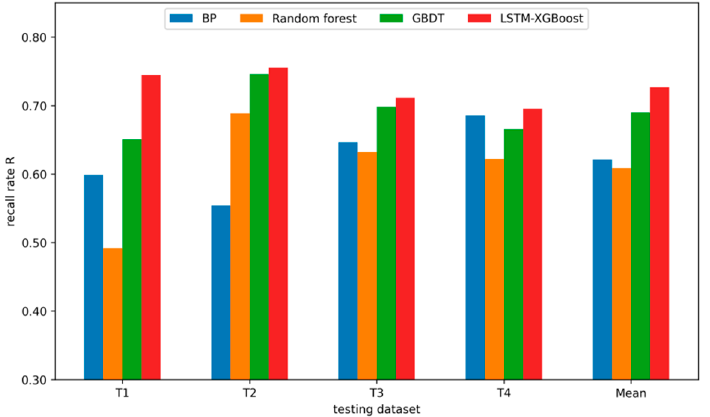
Figure 13. Recall rate R of heavy overload prediction models of public transformer based on each algorithm.